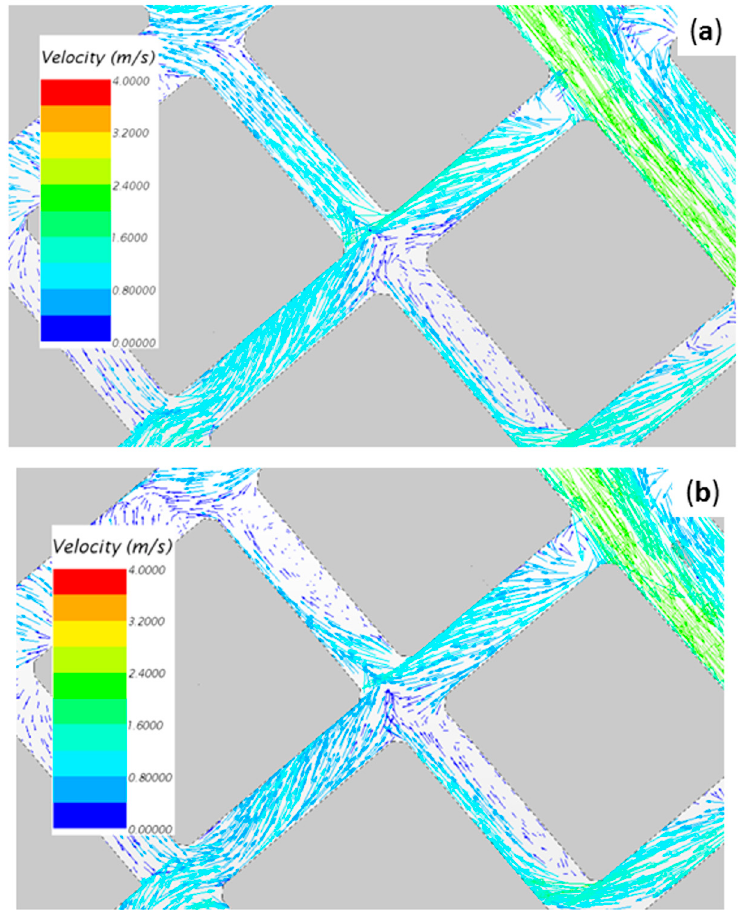
Figure 14. ( a ) Flow pattern in Current-2 case; ( b ) Flow pattern in New-2 case in the area limited by dashed line in Figure 13.